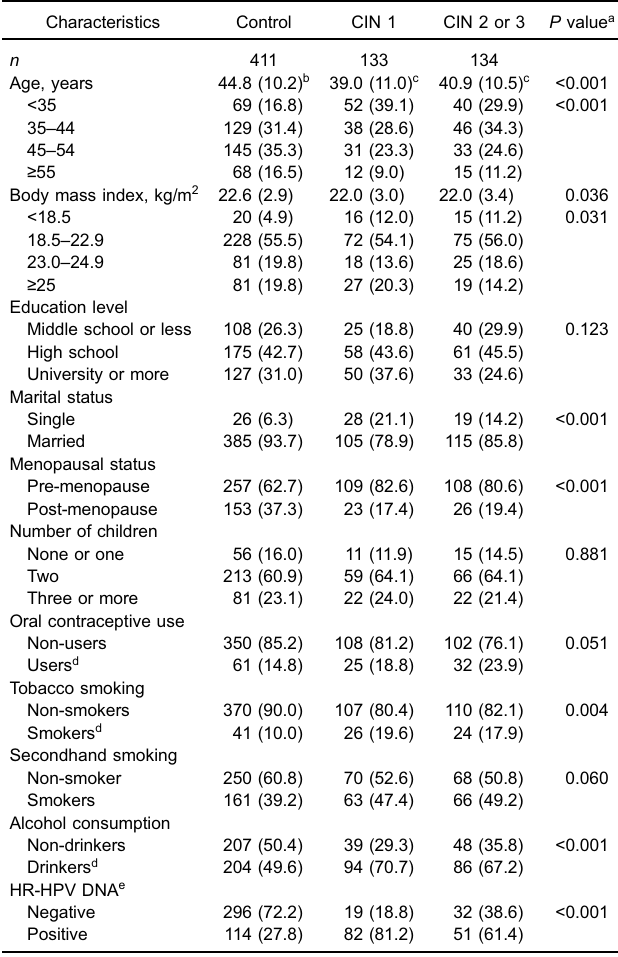
Table 1. General characteristics of study subjects ( n =